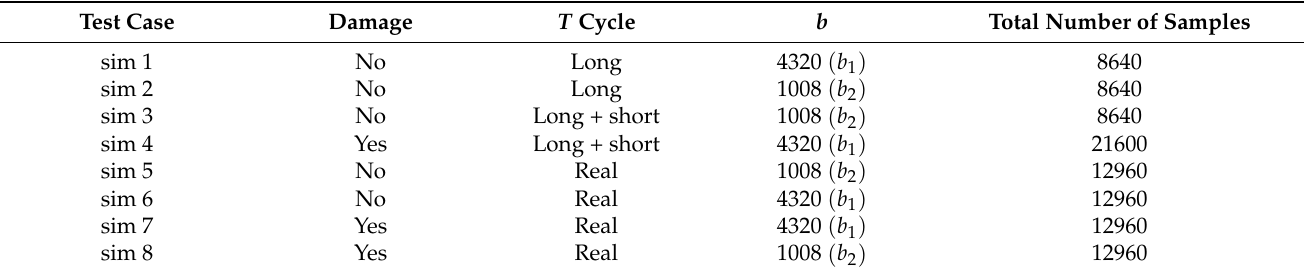
Table 3. Simulated test cases.